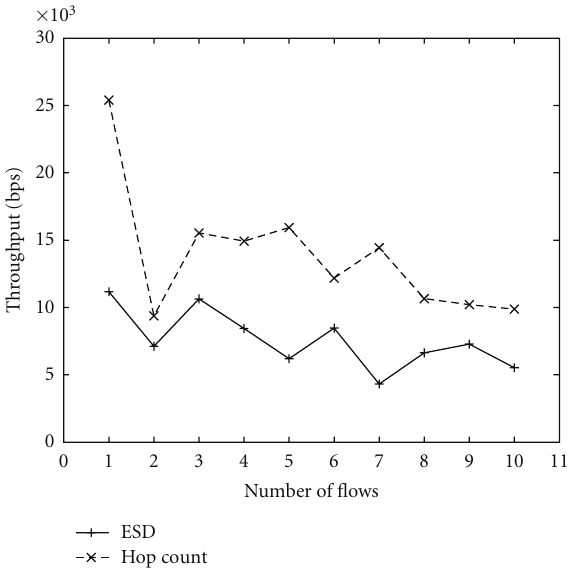
Figure 4: Throughput comparison: ESD metric versus hop count.